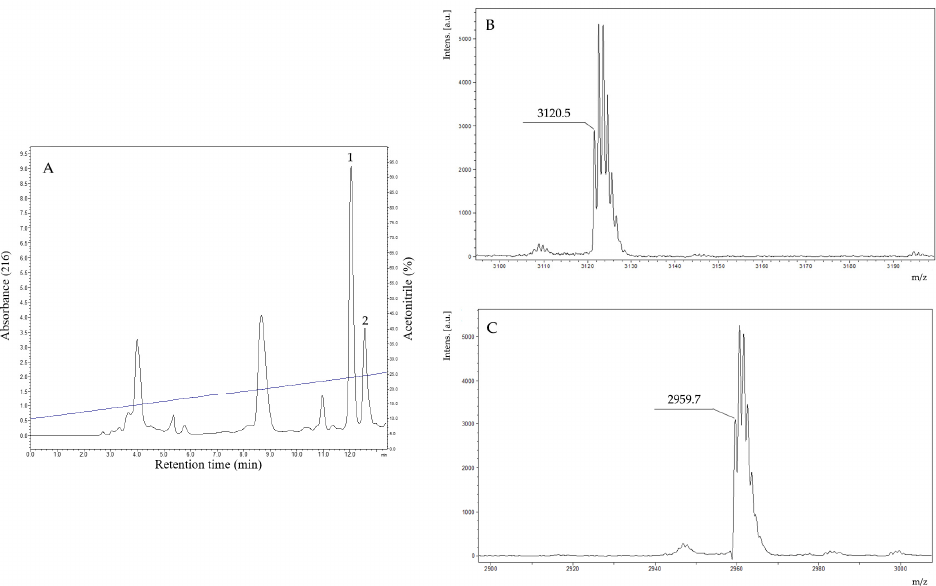
Figure 3. ( A ). Rechromatographic profile of the purification of the antimicrobial fraction found in the crude secretion of B. raniceps , using an HILIC column (Phenomenex Luna 200A, no. H18-129976, 4.6 mm × 250 mm, 5 µm) with a flow of 1 mL/min and detection at 216 nm. The fractions 1 and 2 (obtained after a rechromatographic step) were analyzed by MALDI-TOF MS and resulted in two purified peptides. ( B ). MALDI-TOF mass spectrum of fraction 1 (indicated in Figure 3A) exhibits a major component with a protonated molecular mass [M+H] + of 3120.5 Da. ( C ). MALDI-TOF mass spectrum of fraction 2 (indicated in Figure 3A) exhibits a major component with a protonated molecular mass [M+H] + of 2959.7 Da. The analyses were performed using an AutoFlex II equipment (Bruker, Germany), applying 1 µL of HCCA matrix at 20 mg/mL.